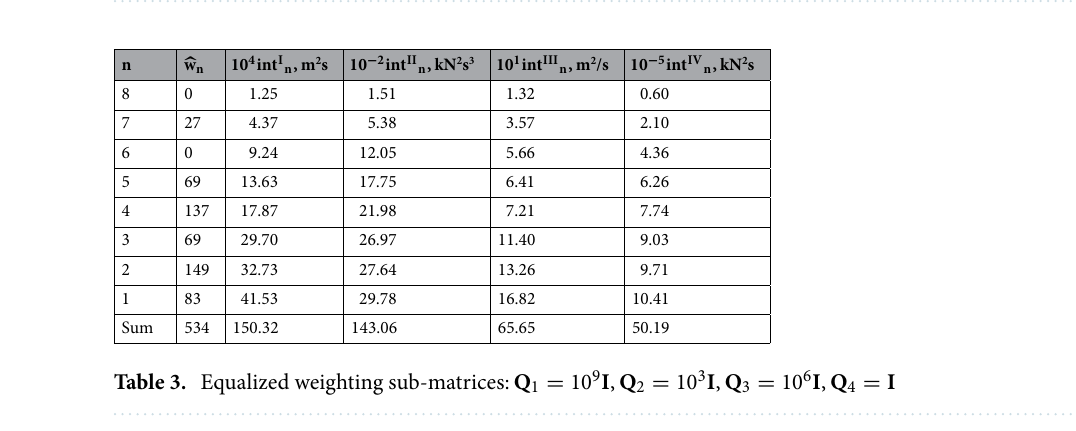
Table 3. Equalized weighting sub-matrices: Q 1 = 10